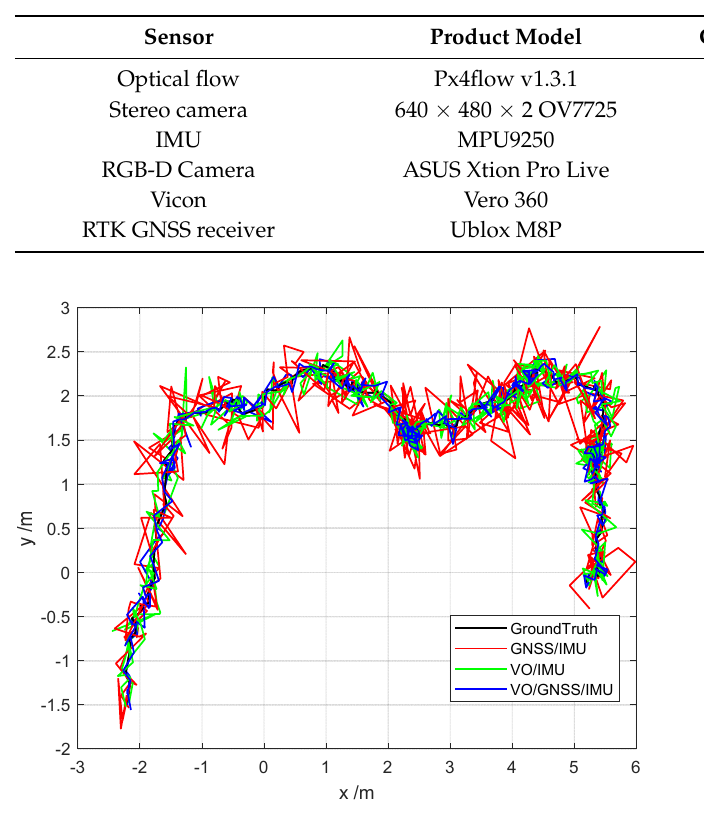
Figure 10. UAV sensor configuration (different sensors and mounting locations for UAV) and “OutBuilding”. Table 4. Sensors and related parameters.